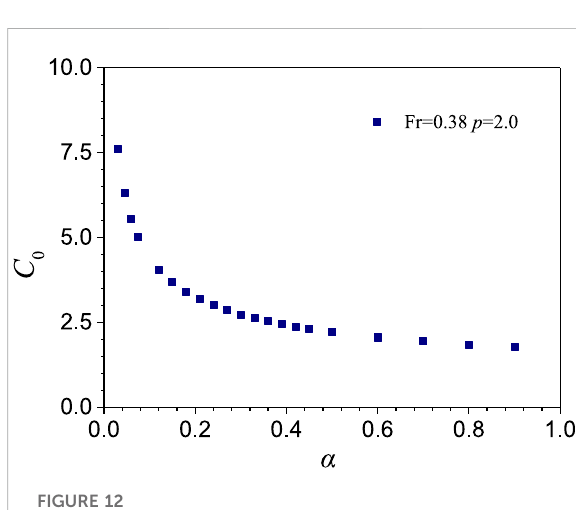
FIGURE 10 Velocity distribution along radial direction under different Reynolds numbers (Fr = 0.38, α c = 0.18, p = 2.0).